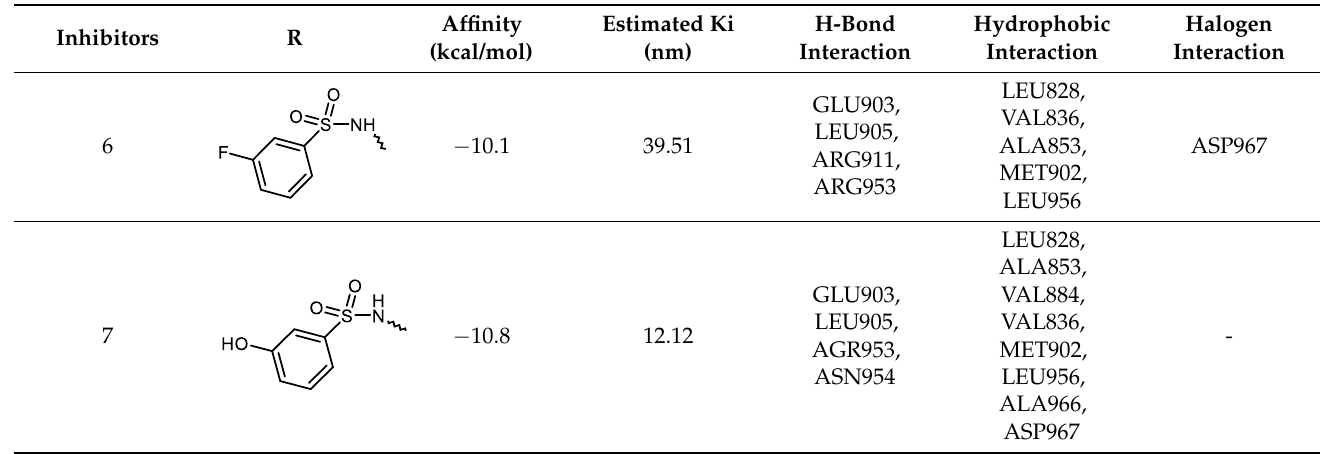
Table 1. Structures of the top 14 inhibitor R-groups and the docking scoring and binding mode of the inhibitor to the receptor (PDB ID:5LWN).